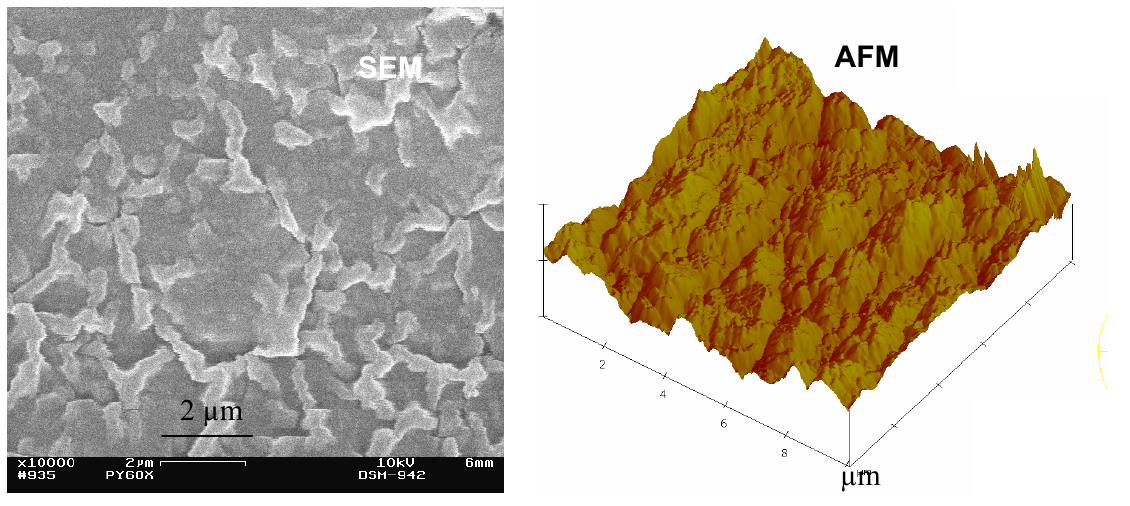
Figure 4. Au electrode coated with a polypyrrole-FeFcGOx